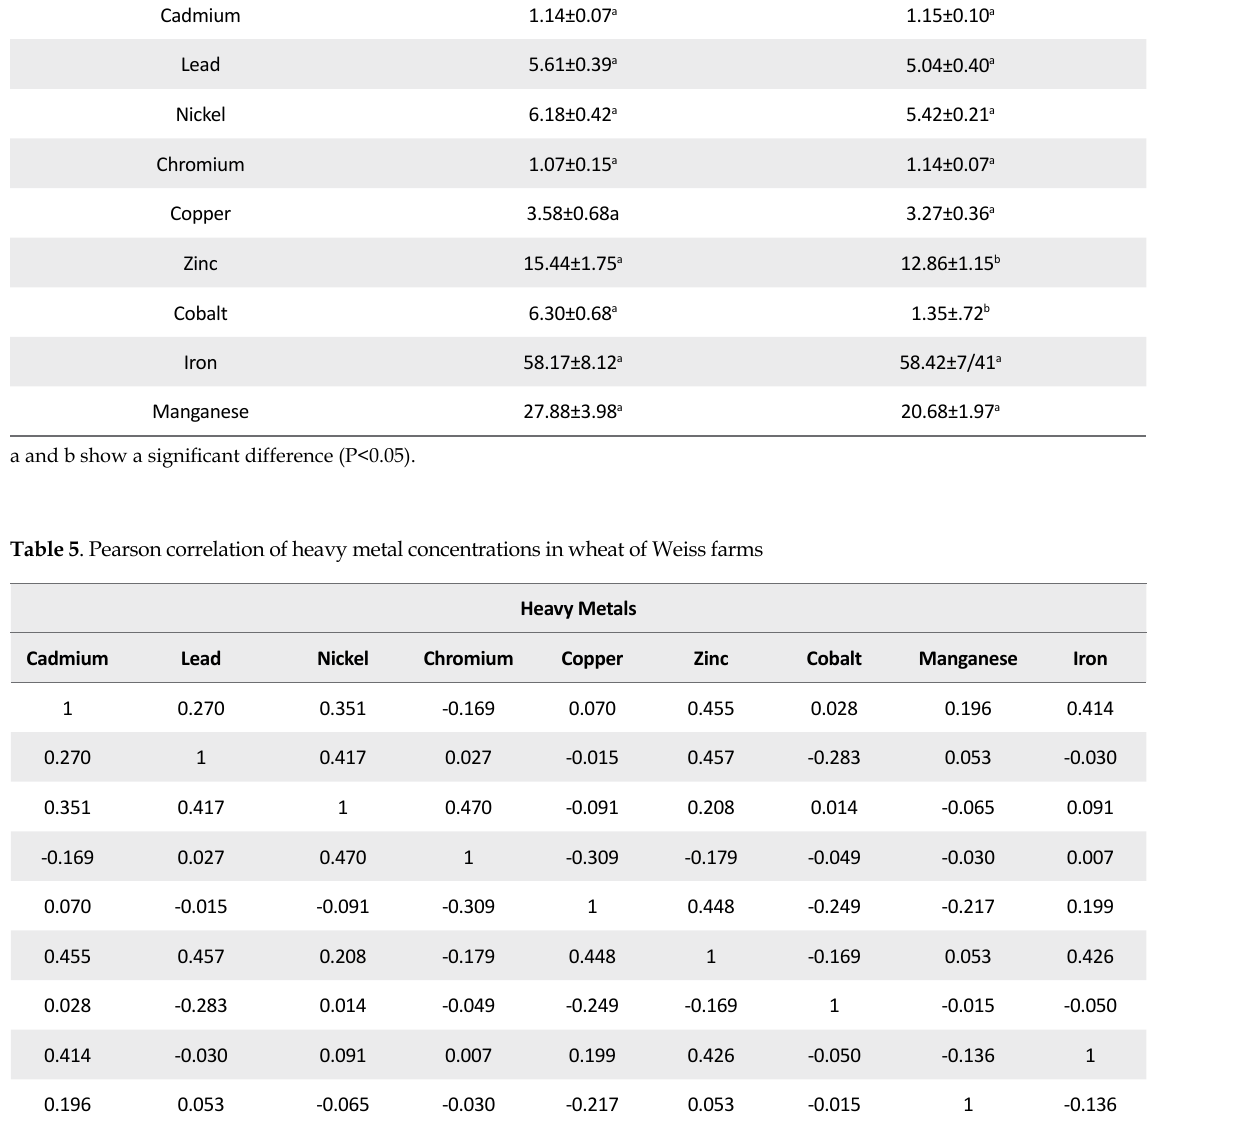
Table 4. Comparison of heavy metals (mg/Kg) of agricultural fields in the Weiss and Arab Assad regions